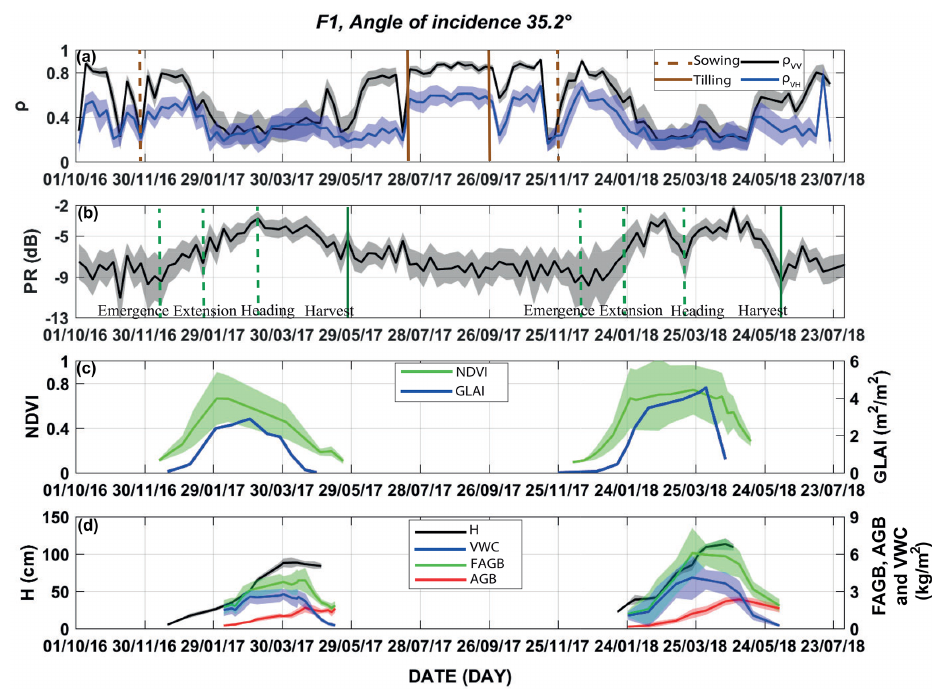
Figure A6. Time series of the interferometric coherence at VV and VH polarizations (a) and the polarization ratio (b) on F1 at a 35.2 ◦ incidence angle during the period from 1 October 2016 to 31 July 2018. The tilling works and phenological stages of wheat are superimposed in panels (a) and (b) , respectively. The NDVI and measured GLAI are displayed in panel (c) . Measured H , FAGB, VWC and AGB are plotted in panel (d) . Time series are presented by mean values (solid lines) and standard deviations (shading surrounding the solid lines).